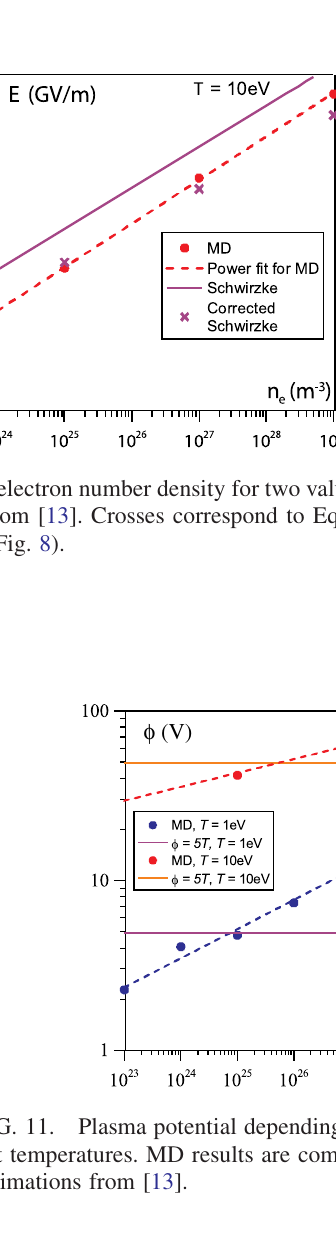
FIG. 9. The ratio between the sheath lengths obtained from MD and the Debye length for different temperatures (see the legends) depending on (a) the electron number and (b) the plasma nonideality parameter.